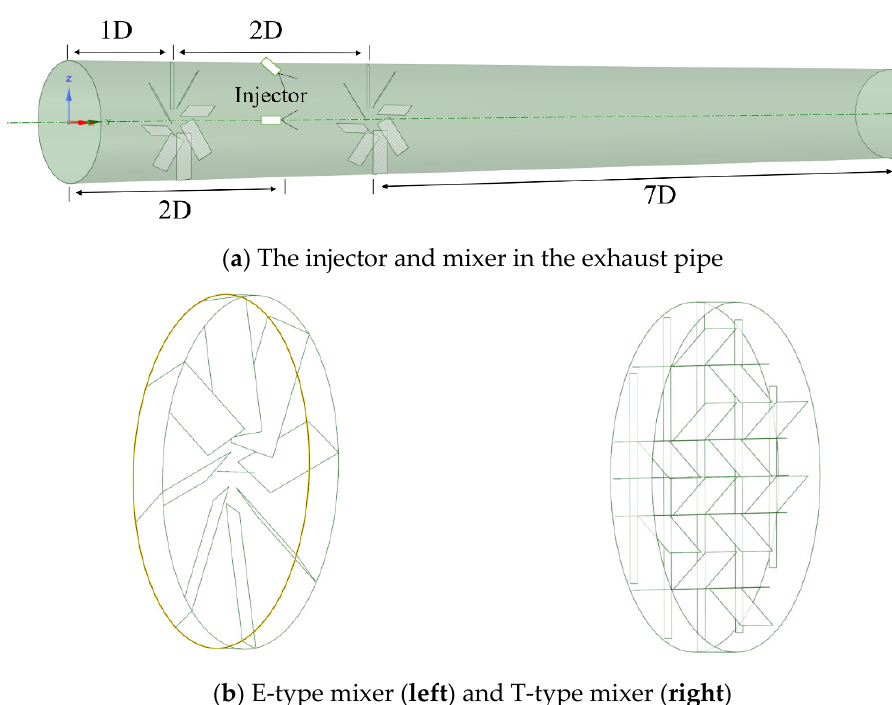
Figure 1. The injection geometrical structure of the selective catalytic reduction (SCR) system.